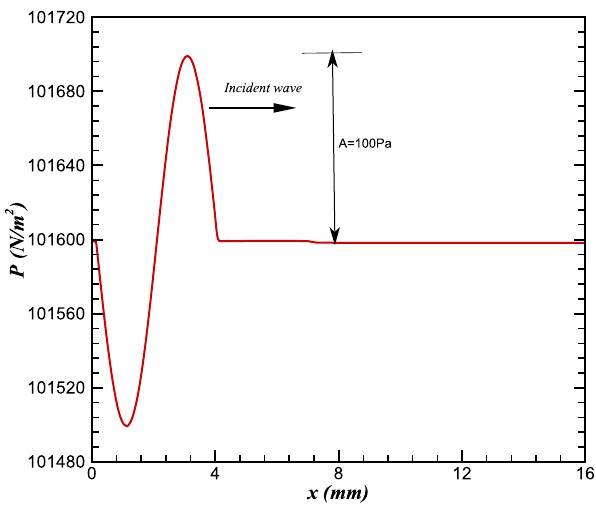
Figure 4. Transmitted and reflected waves.